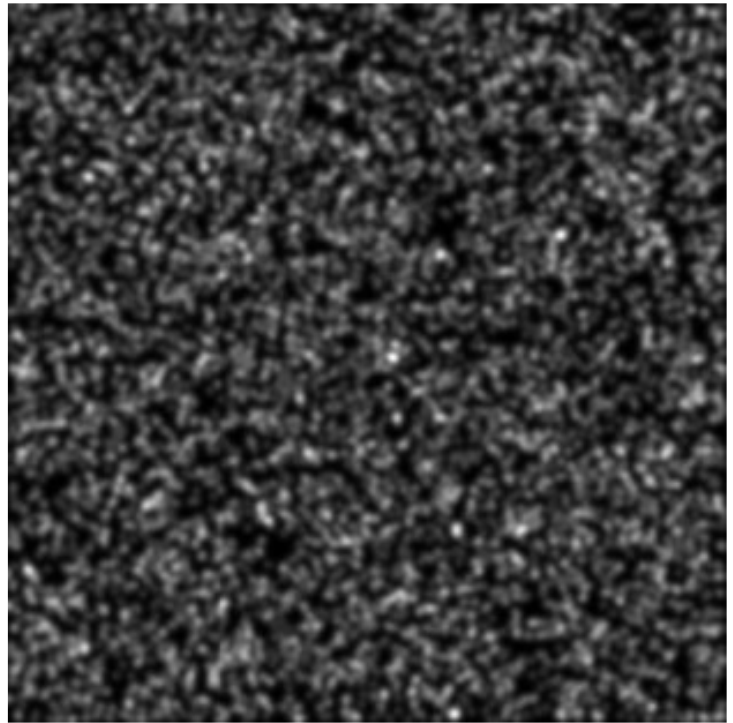
Figure 5. Speckle image before